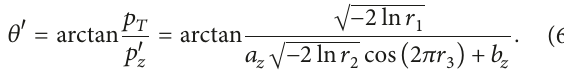
where 𝜎 represents a distribution width. The